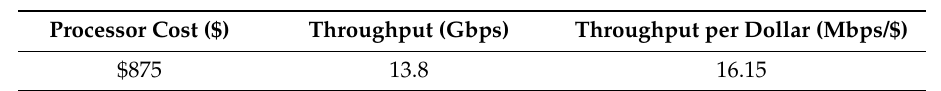
Table 3. LHPMA efficiency per cost.